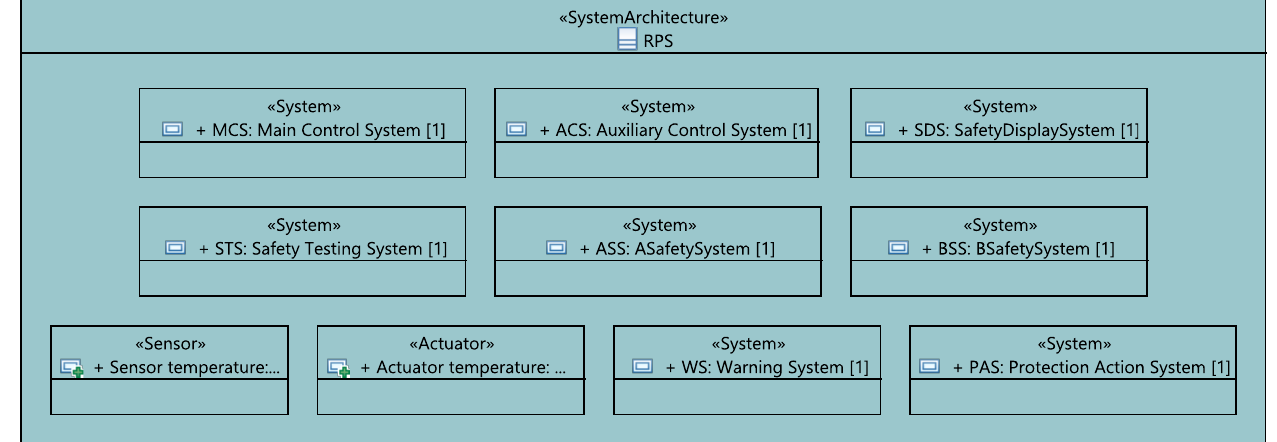
Figure 16. RPS sub-systems, sensors and actuators.